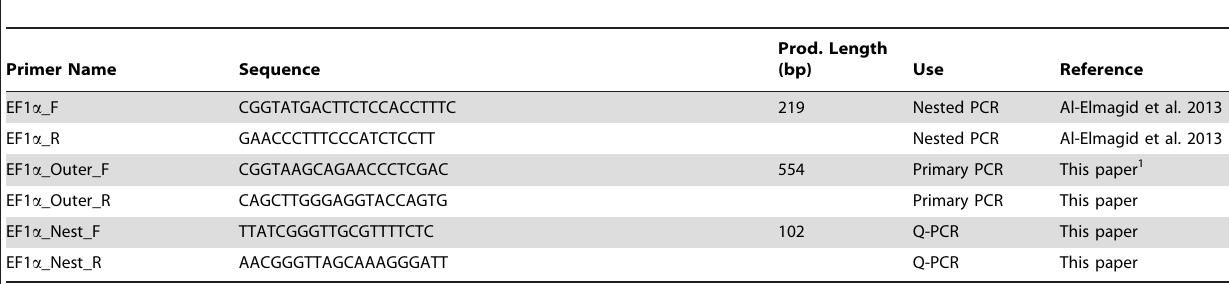
Table 3. Primers used for molecular detection of S. homoeocarpa in creeping bentgrass commercial seed